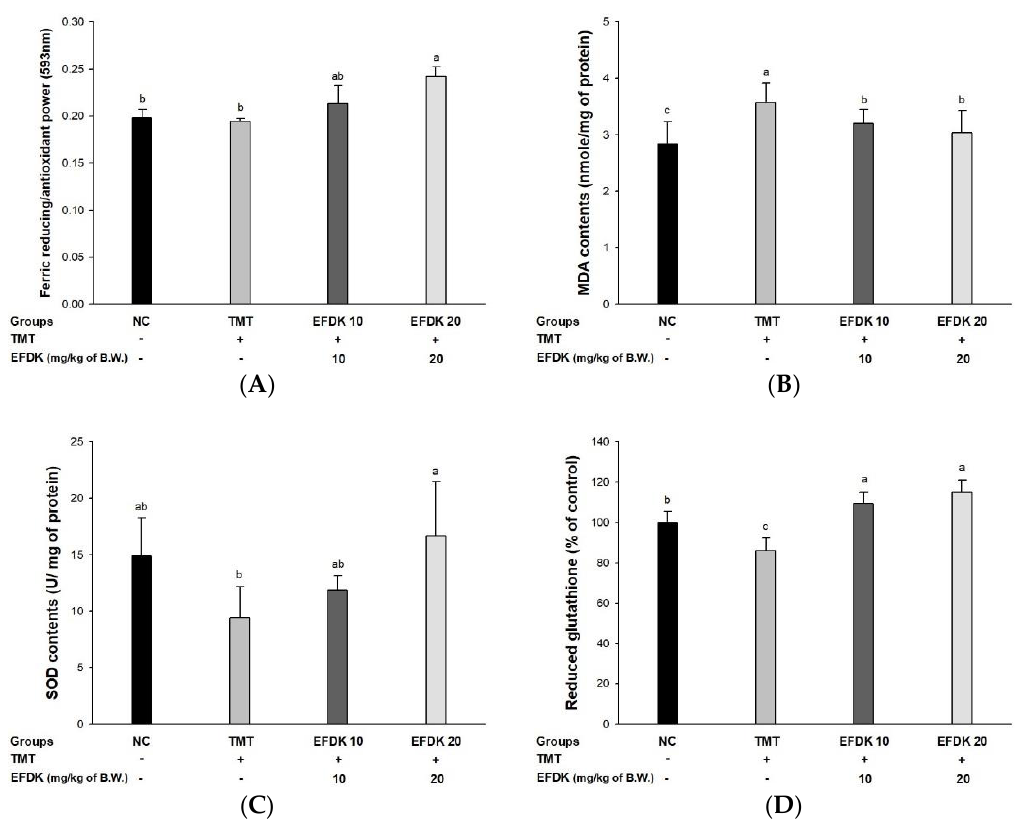
Figure 5. Protective effect of ethyl acetate fraction from persimmon (EFDK) on TMT-induced biochemical changes related with antioxidant system. ( A ) Plasma ferric-reducing ability of plasma (FRAP); ( B ) MDA levels; ( C ) superoxide dismutase (SOD) contents; ( D ) reduced gluthathione (GSH) levels in mice brain tissues. Results shown are mean ± SD ( n = 8). Data were statistically represented at p < 0.05, and different small alphabets mean statistical significance.